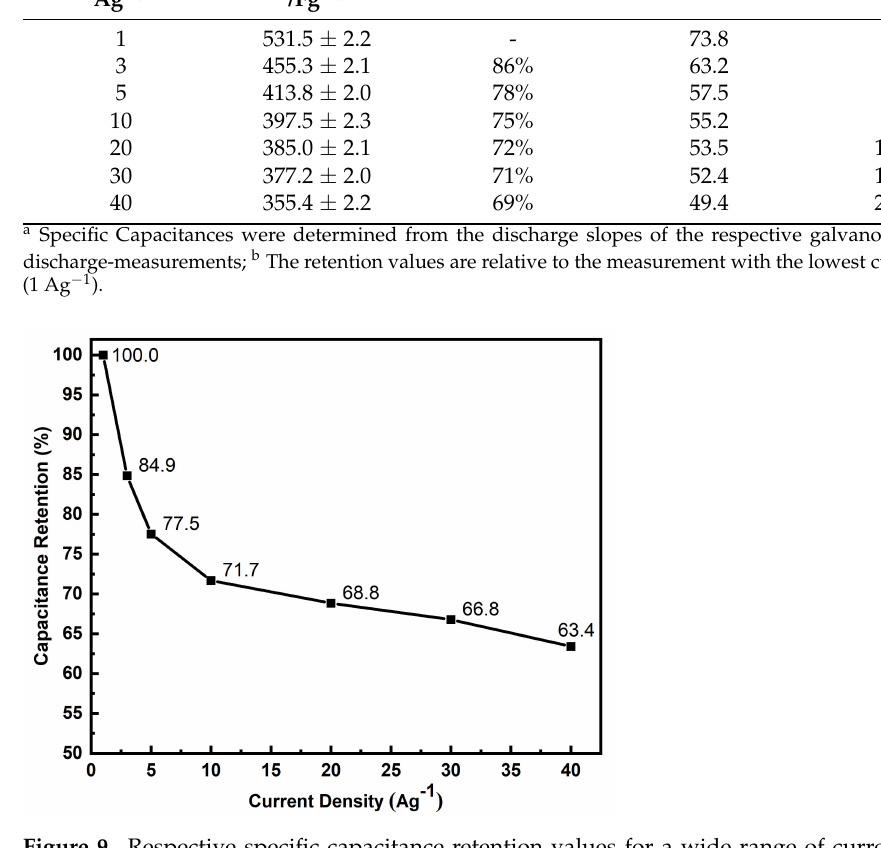
Figure 9. Respective specific capacitance retention values for a wide range of current densities ranging from 1 Ag − 1 to 40 Ag − 1